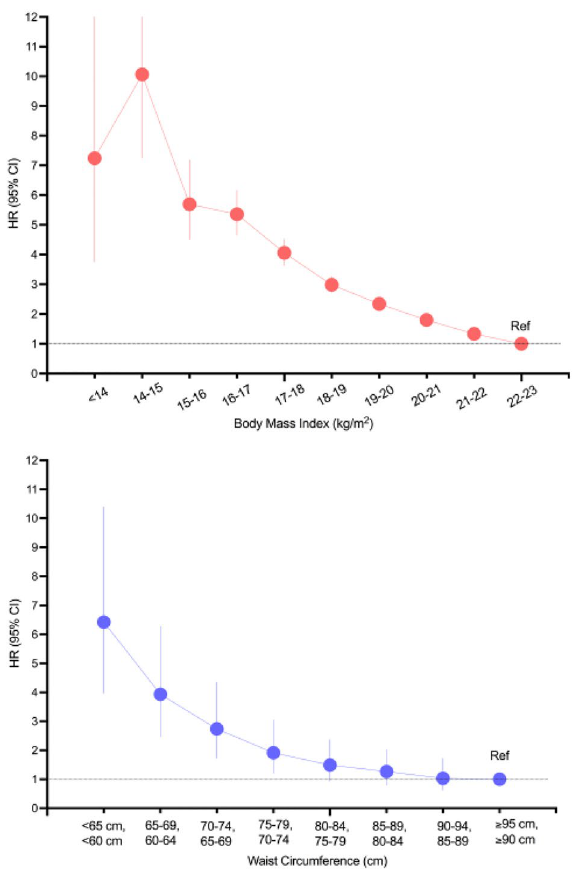
Figure 2. Hazard ratios (HRs) and 95% confidence intervals of non-tuberculous mycobacterial pulmonary disease according to body mass index (BMI) or waist circumference (WC). The group with baseline BMI 22–23 kg/m 2 or WC ≥ 95 cm in men/ ≥ 90 cm in women was considered the reference group. Adjusted for age, sex, smoking, alcohol drinking, regular exercise, respiratory diseases, solid cancer, hematologic malignancy, transplantation, AIDS, GERD, connective tissue disease,